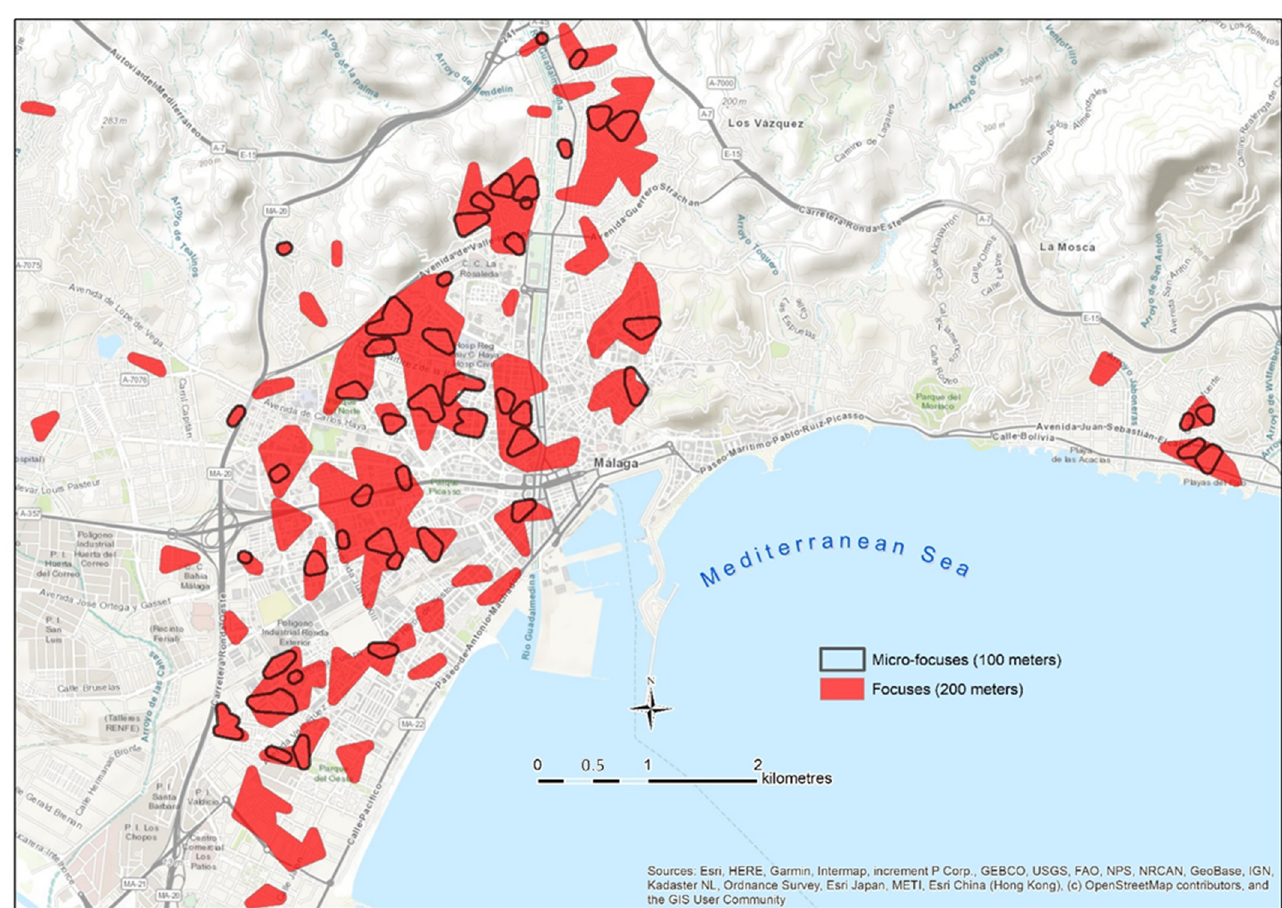
Figure 9. Superposition of micro-focuses and focuses of contagion in Málaga for the second period of August (17 August